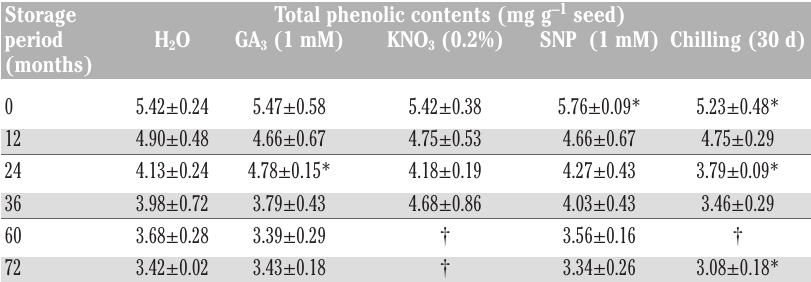
Table 1. Effect of different seed pre-treatments on total phenolic contents of differential- ly stored seeds of H. niger. Data are average of 3 measurements each ± s.d.